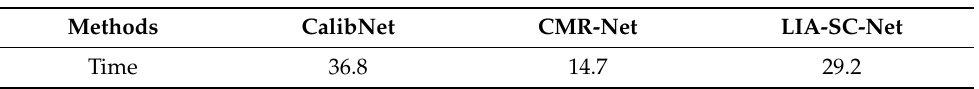
Table 7. Runtime comparison with deep learning based methods in the validation dataset (Unit: